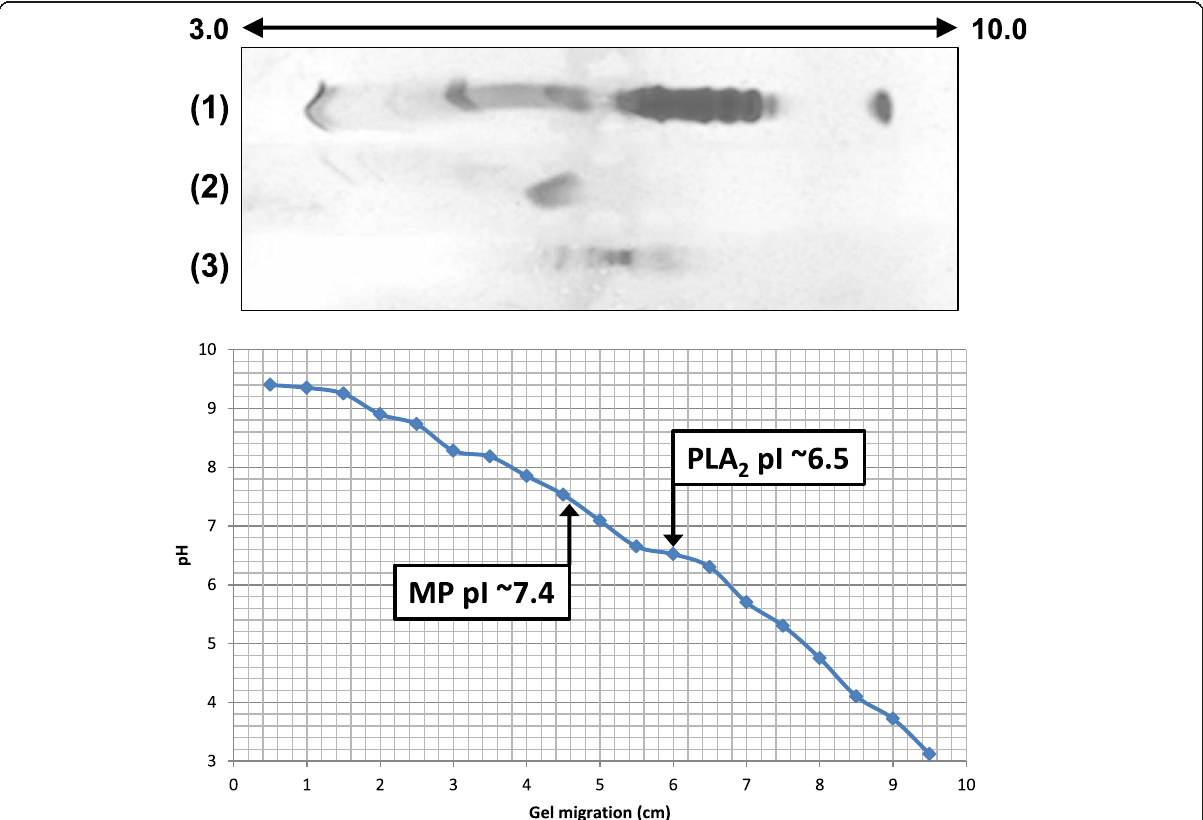
Fig. 6 Isoelectric focusing of the toxins isolated from B. atrox venom on a 7 % polyacrylamide gel. Samples: (1) isoelectric focusing standard (IEF Standards, pI ranges from 4.45 to 9.6, Bio-Rad, USA), (2) PLA 2 (pI ~6.5) and (3) MP (pI ~7.4). The pI of samples was calculated from the curve of pH versus the migration distance in the